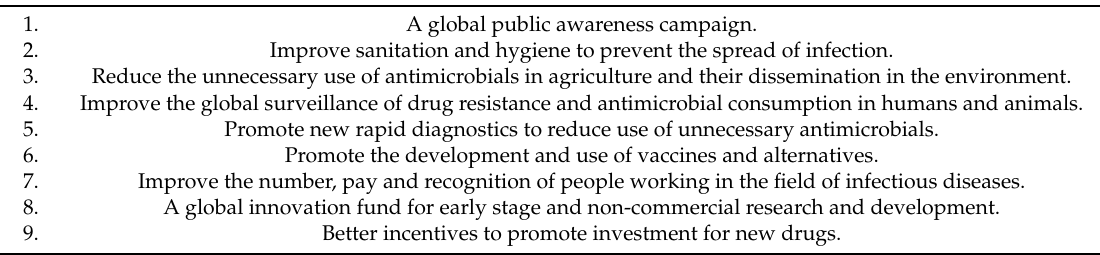
Table 1. Major areas of intervention to combat antimicrobial drug resistance [3].